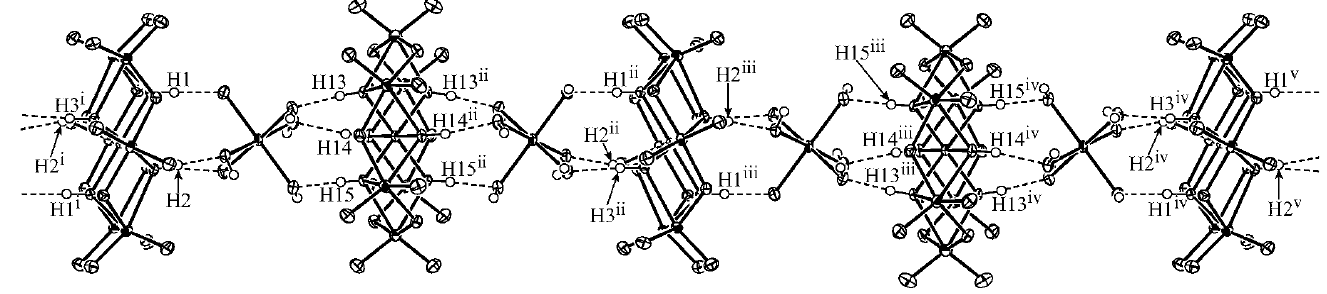
Figure 2 The hydrogen-bonded polymer formed by [H 6 PtMo 6 O 24 ] 2 (cid:2) and [Pt(OH) 6 ] 2 (cid:2) anions. [Symmetry codes: (i) (cid:2) x + 1 (cid:2) y + 1 , z + 1 ; (iv) (cid:2) x (cid:2) 1 , (cid:2) y + 1 , (cid:2) z + 1; (v) x (cid:2) 1, y , z + 1.] 2 2 2 2